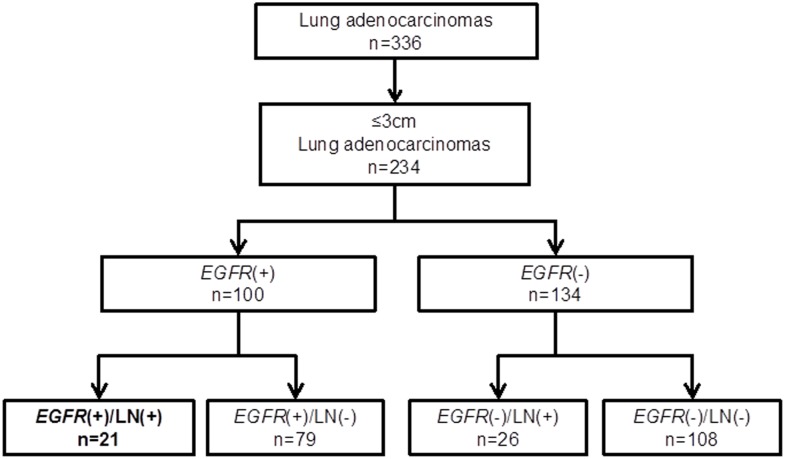
The flowchart used to assign the tumors to the four groups.n, number of tumors; EGFR, EGFR mutation; LN, lymph node metastasis; +, positive; -, negative.